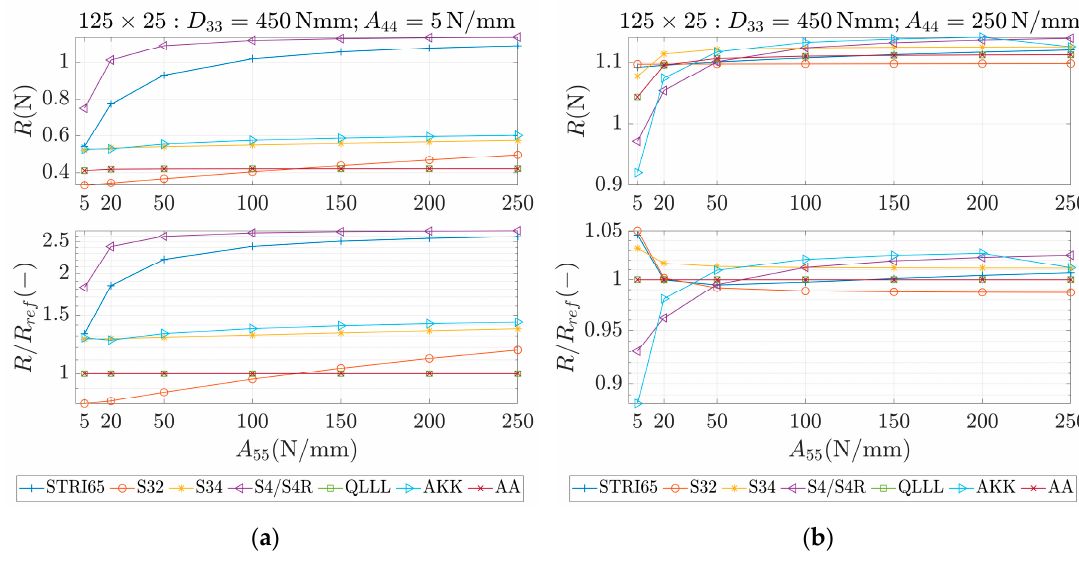
Figure 9. Reactions (first row) and reactions to the reference (analytical) solution (second row) for 125 × 25 sample, 𝐷 (cid:2871)(cid:2871) = 450 Nmm and different values of 𝐴 (cid:2872)(cid:2872) . ( a ) 𝐴 (cid:2873)(cid:2873) = 5 N/mm and ( b ) 𝐴 (cid:2873)(cid:2873) = 250 N/mm.